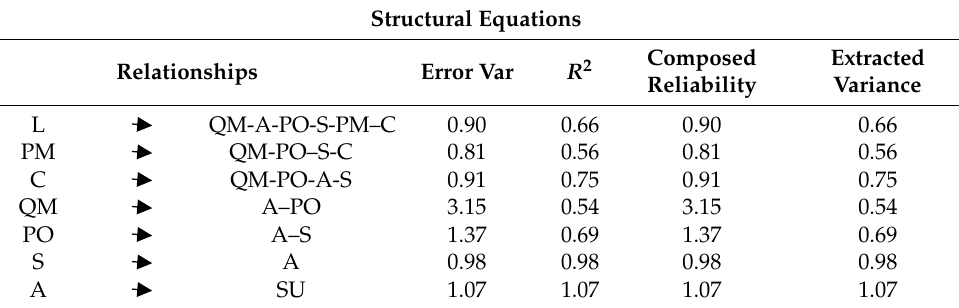
Table 4. Covariance matrix for the latent variables.